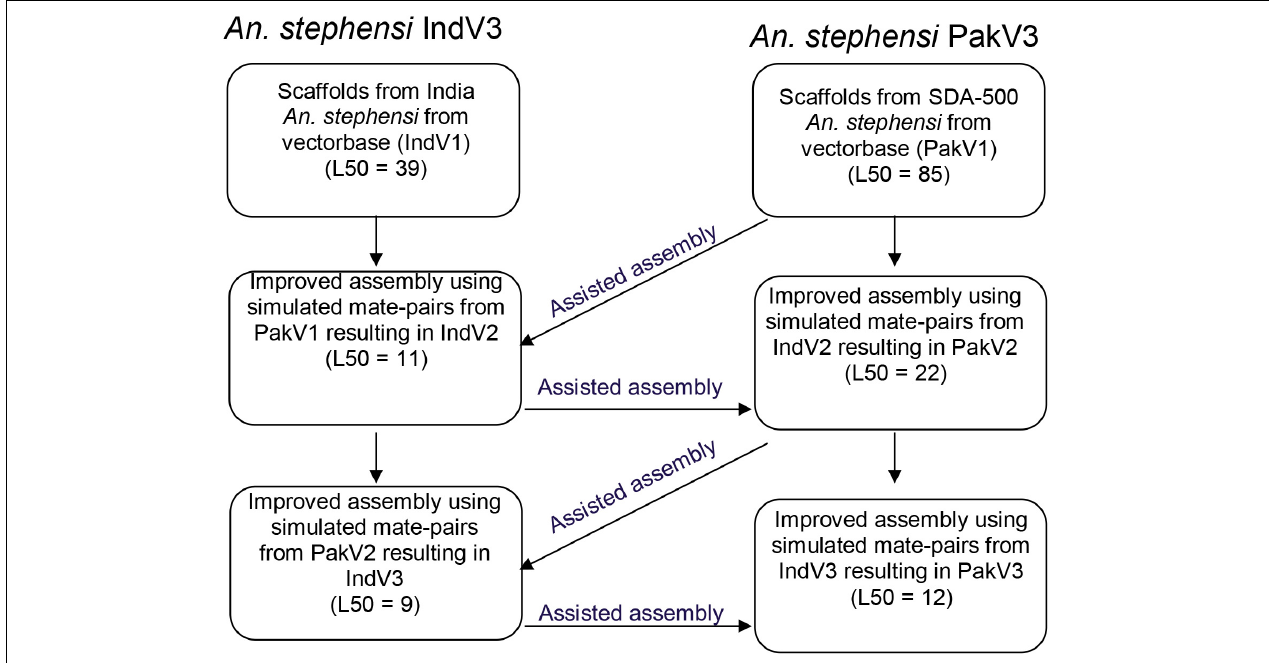
FIGURE 1 | Schematic diagram showing the iterative approach followed to improve the assemblies of both strains of An. stephensi .